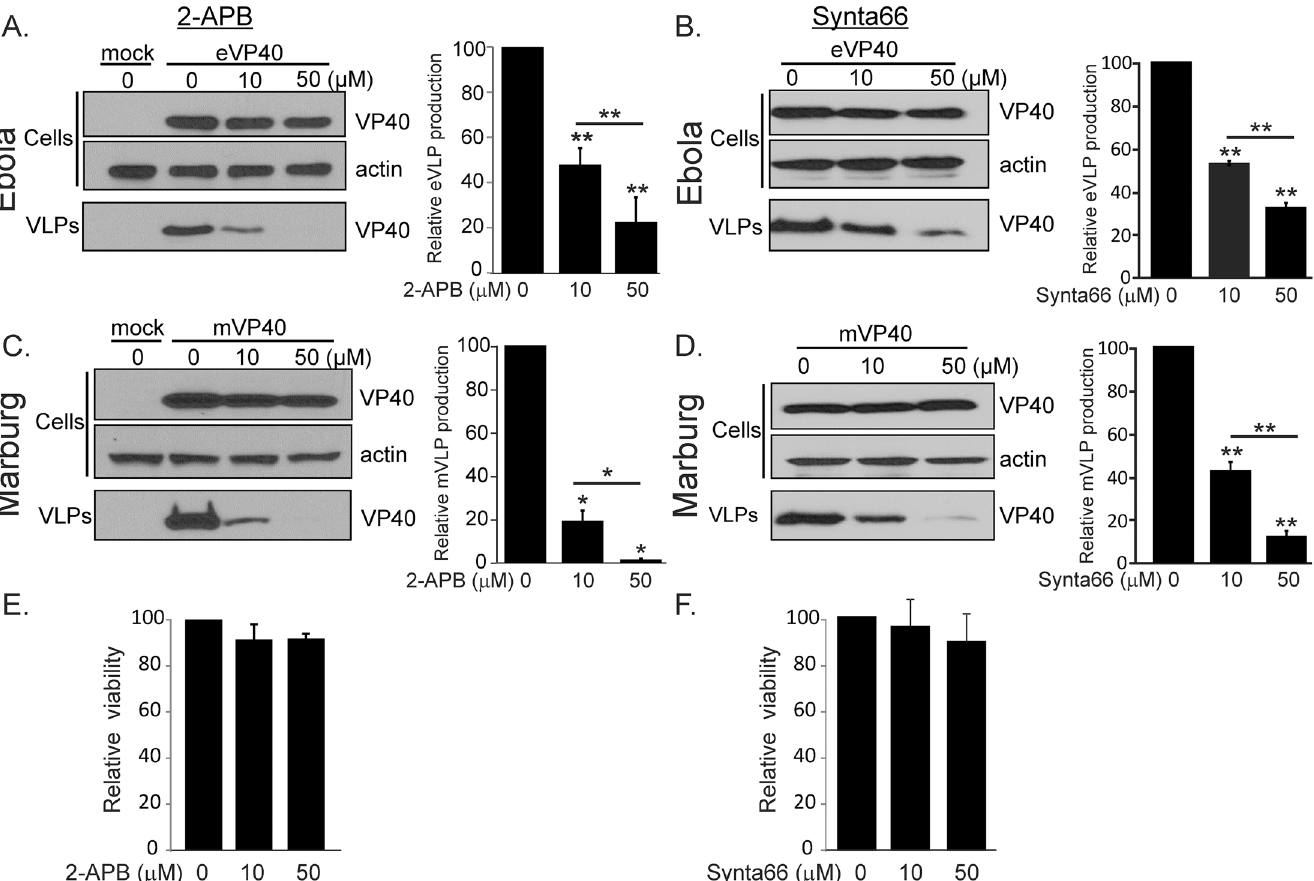
Fig 4. Pharmacological effect of Synta66 and 2-APB on egress of filovirus VLPs. HEK293T expressing eVP40 ( A and B ) or mVP40 ( C and D ) were treated with indicated concentrations of 2-APB or Synta66. eVP40 and mVP40 levels in cell extracts and VLPs were detected by immunoblot analysis and quantified in VLPs (bar graphs). 2-APB (E) and Synta66 (F) cytotoxicity was assessed with an MTT viability assay under conditions that mimicked those used for the VLP experiments. In all experiments, cellular actin served as a loading control. Relative protein bands densities were normalized to untreated sample densities (0 μ M). Plotted values represent the average (+/- S.E.M) of 3 – 6 independent experiments and were analyzed with either Welch's t-test or Wilcoxon rank-sum test ( * p = 0.01, ** p = 0.05).